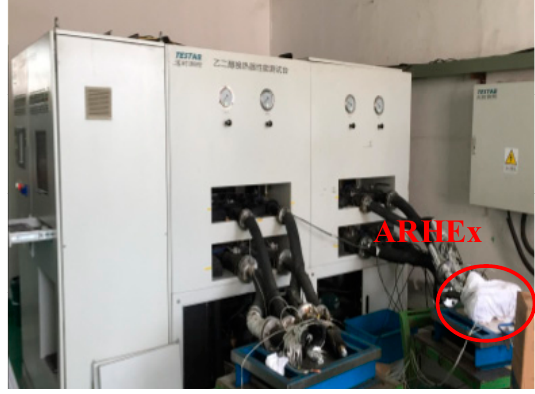
Figure 5. Experimental device.